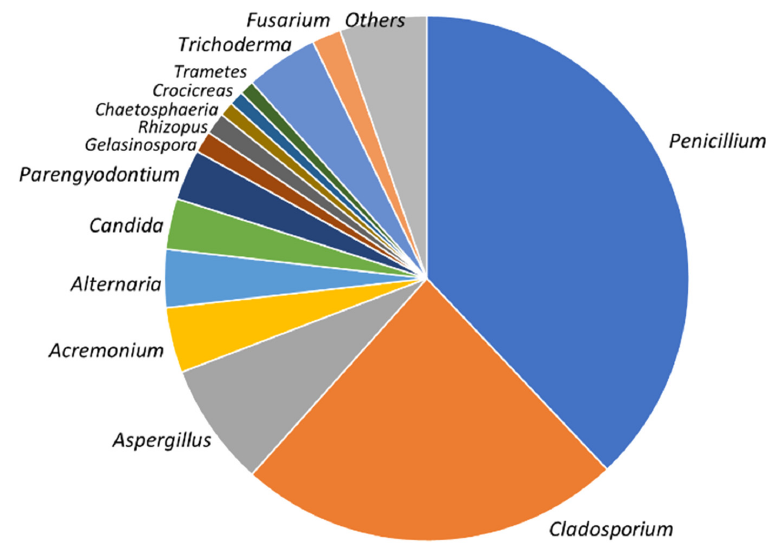
Figure 2. Relative abundance of culturable fungal genera isolated from Agelas oroides. Table 2. Fungal taxa found in association with Agelas oroides . Genes, in Addition to ITS, Used Number of for Molecular Identification (“-“ Taxon Isolated Indicates No Additional Genes Were Analyzed) Penicillium steckii Strains